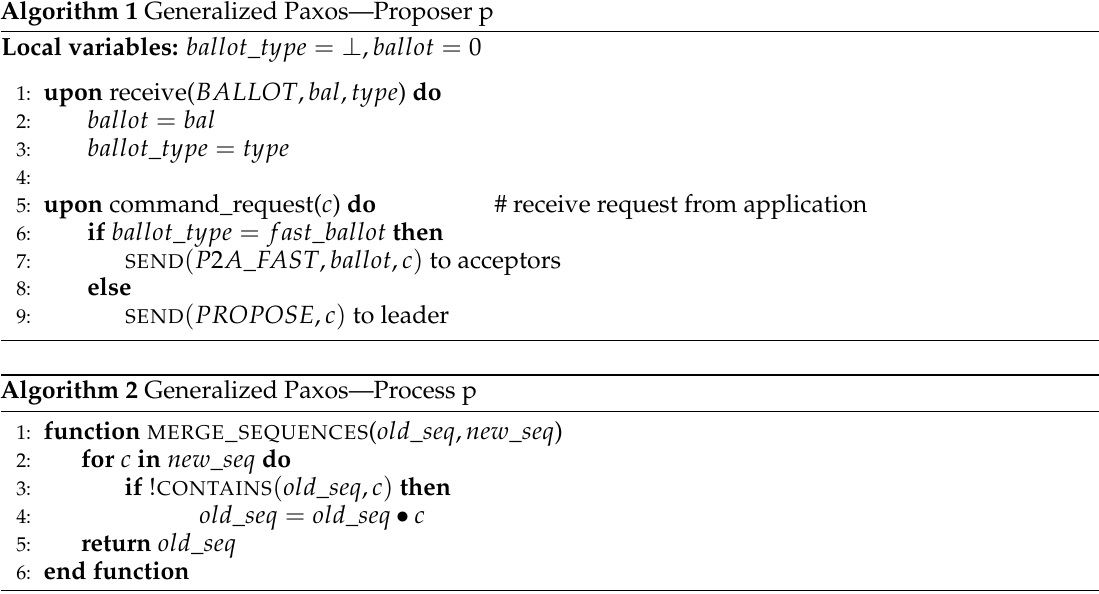
Algorithm 1 Generalized Paxos—Proposer p